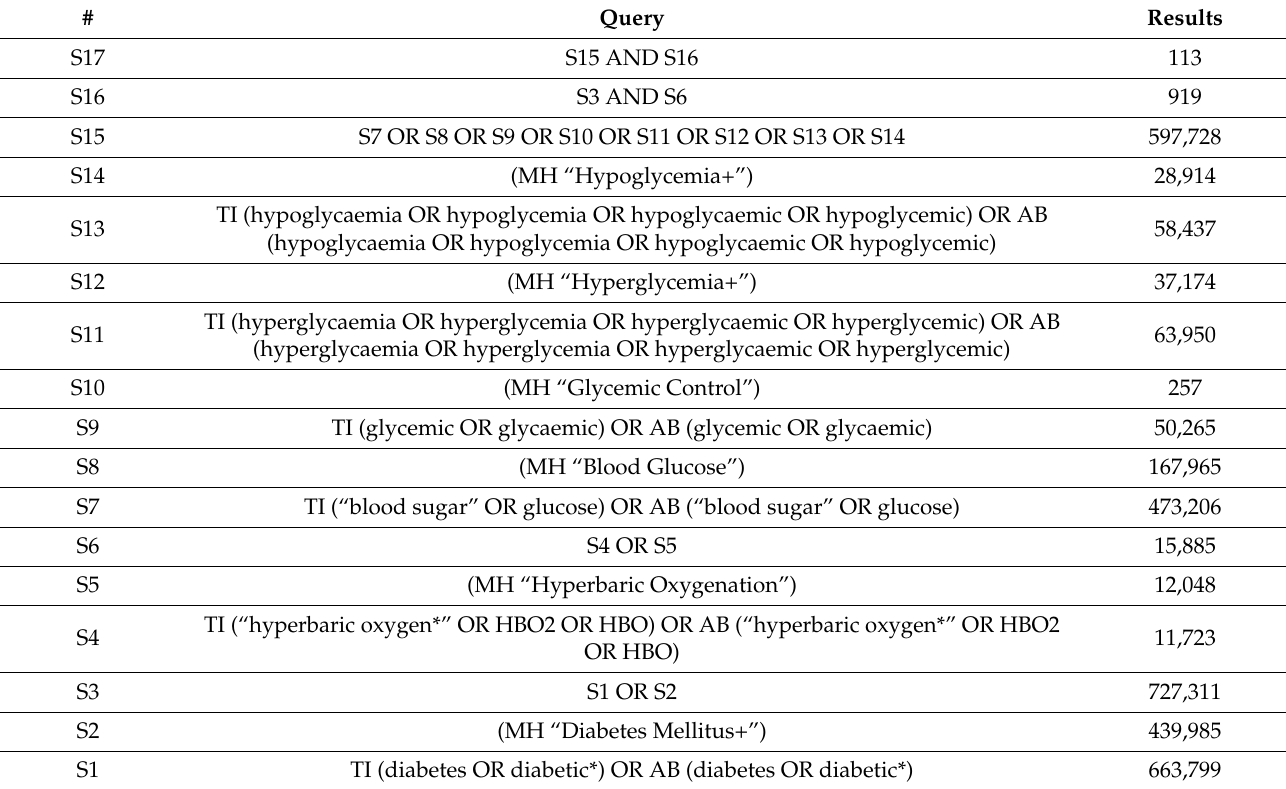
Table A2. Demonstrating the search strategy used on the Medline database.